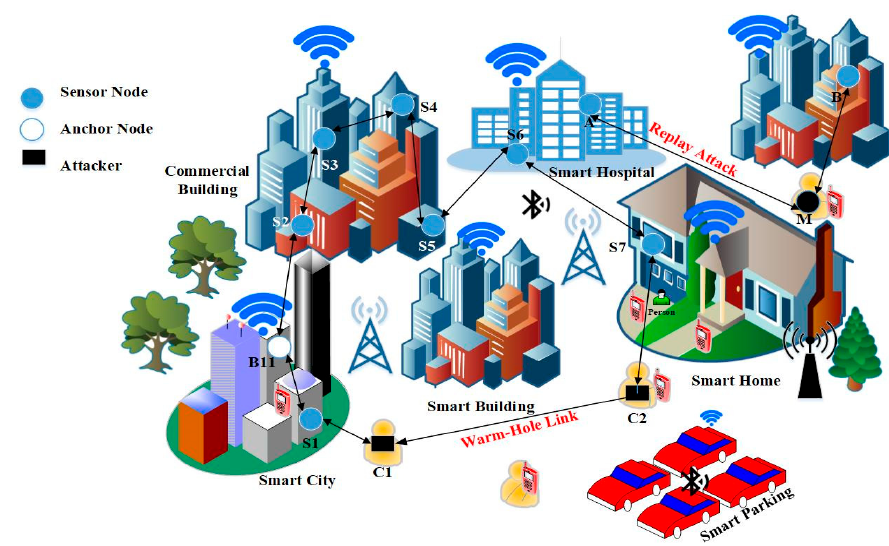
Figure 1. Representation of a wormhole attack and replay attack.